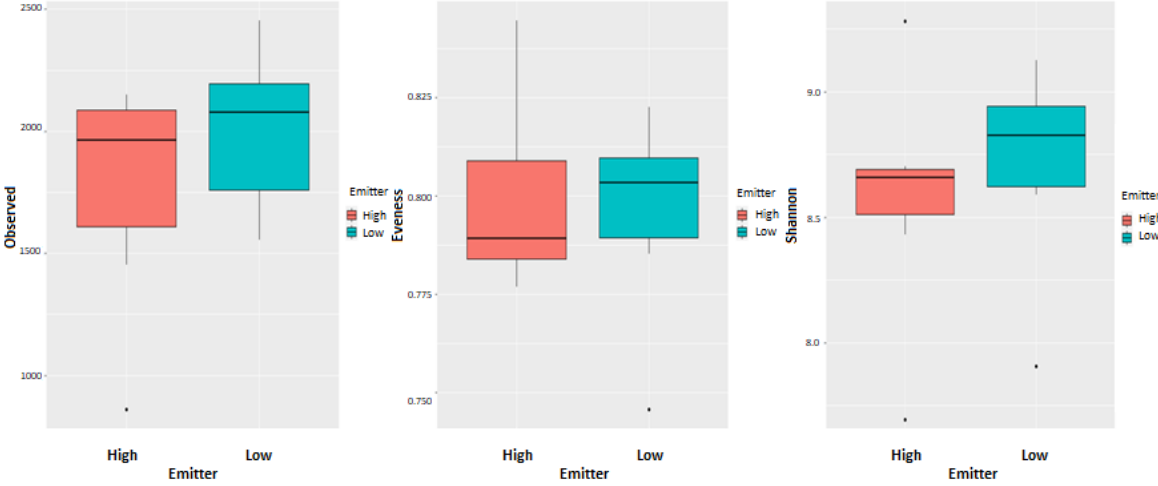
Figure 3. Alpha diversity analysis. Boxplots representing variations in alpha diversity in the rumen fluid: high (red) and low (green) emitters respectively. Alpha diversity metrics include observed OTUs, Evenness, and Shannon indexes are for both bacteria and archaea. High n = 7, Low n = 7.